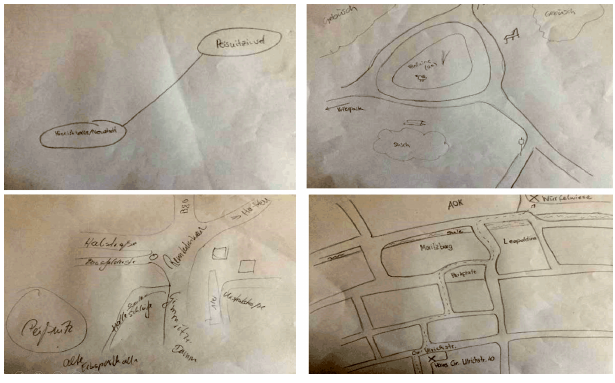
Fig. 5 . Different types of mental representations of green-blue infrastructure (GBI) users in Halle-Newtown: Type A (upper left) refers to the origin and destination of the walk/way; Type B (upper right) focuses much more on details like shopping facilities, a streetlamp, and a bench; Type C (lower left) entered all street names describing the walk/way with particular focus on the riparian Peißnitz Island; whereas Type D (lower right) represents those respondents who have drawn map-like